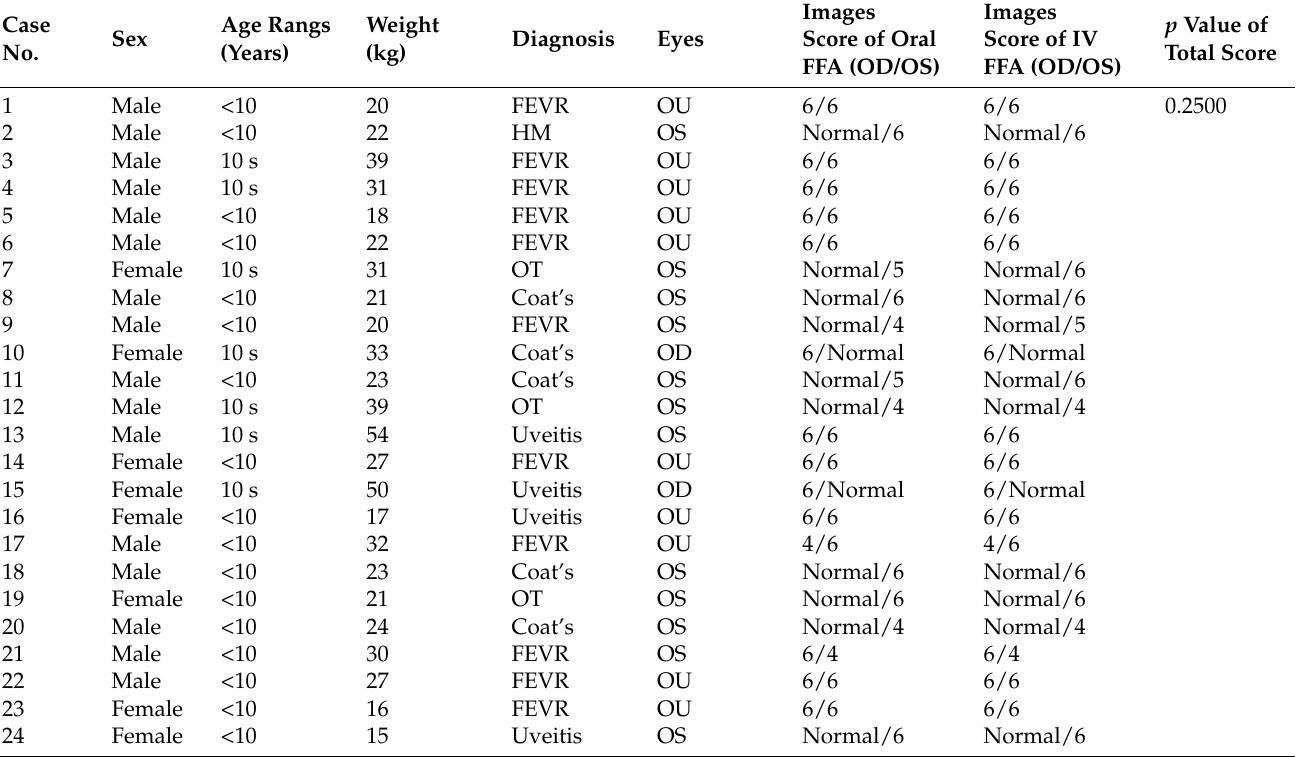
Table 1. Demographic Characteristics and Image Sores of 24 Pediatric